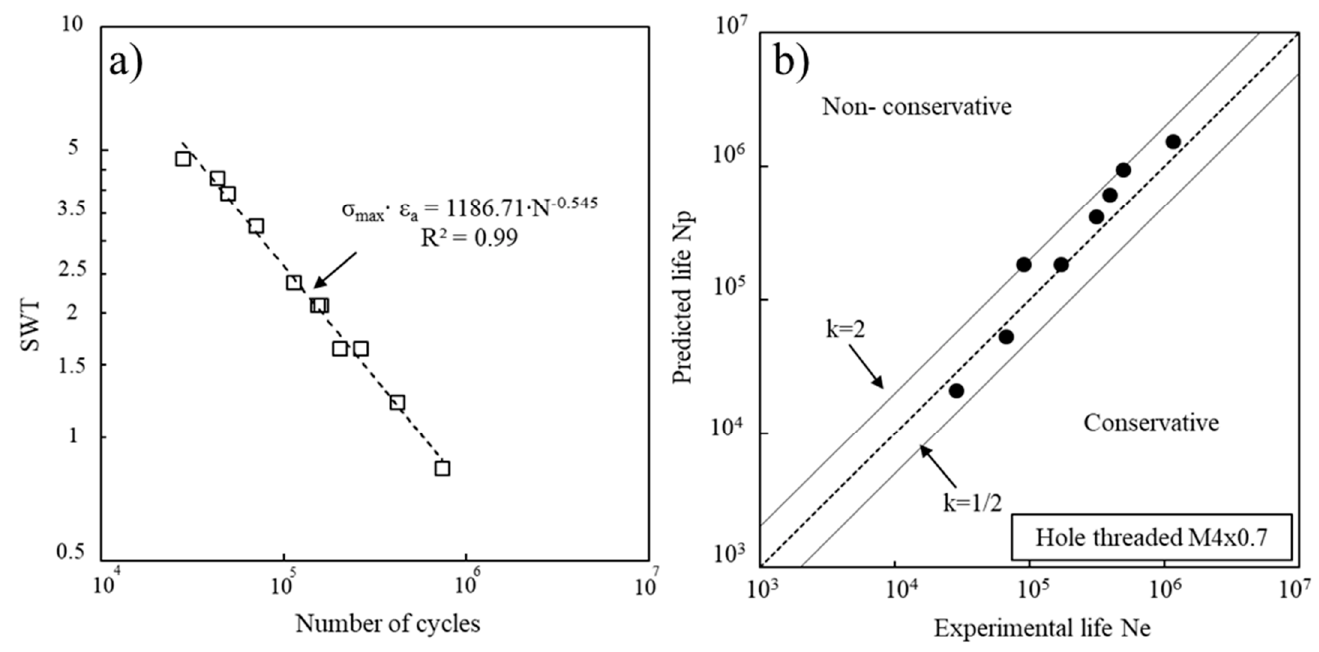
Figure 9. ( a ) SWT parameter vs. number of cycles to failure for the hole as manufactured series; ( b ) Fatigue life predictions vs. experimental fatigue lives for the hole thread series.